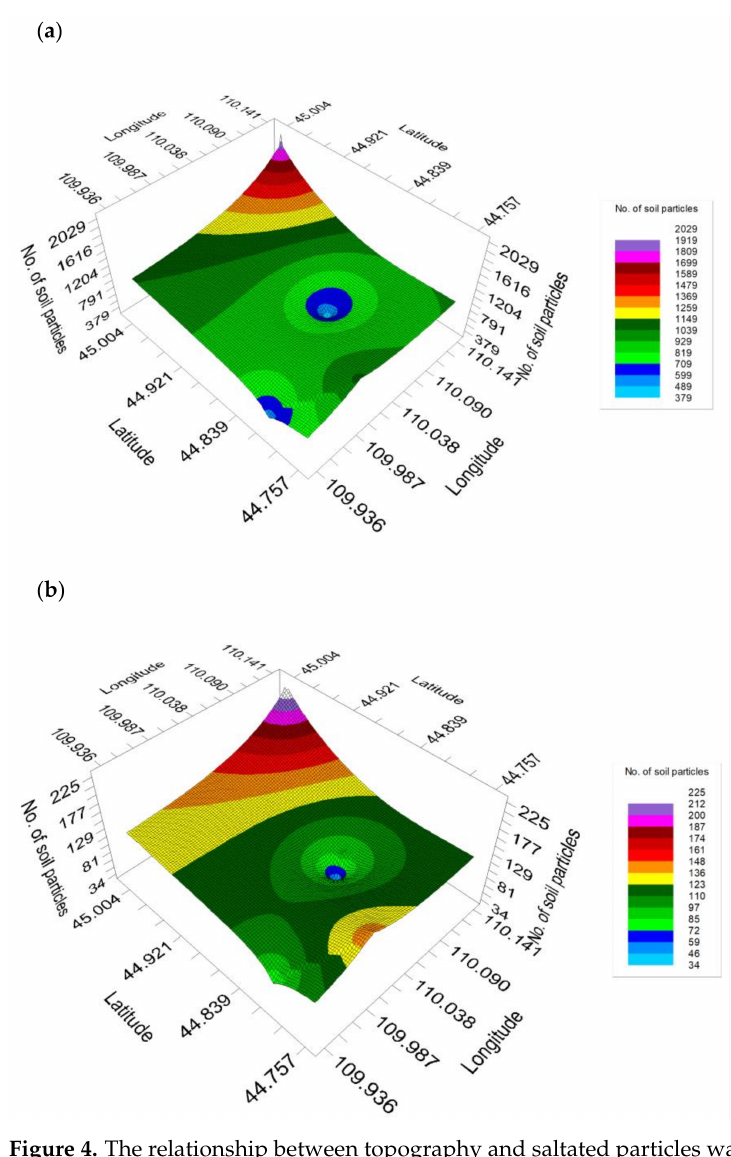
Figure 4. The relationship between topography and saltated particles was analyzed and drawn by GS + Geostatistics. The figure shows the dust scattering concentration at a critical wind speed of 9 m/s with latitude and longitude. ( a ) is 3 µ m particles, and ( b ) is 5 µ m particles. The number of bacteria on the ground surface at the four locations was detected at the DL (10 7.0 CFU/g), the WA (10 6.5 CFU/g), the WE (10 7.3 CFU/g), and the DS (10 6.4 CFU/g), and the saltation experiment revealed that approximately 1/1000 of the number of live bac- teria was saltated. Next, the total number of bacteria obtained from the culture of saltated bacteria in a container installed in the experiment tent was examined. In the examination of the number of saltated bacteria at four locations, 10 4 –10 4.9 CFU/g was detected for 10 min blown by the fan. The WE had the largest number of bacteria (10 7.3 CFU/g) detected from the ground surface, and the number of saltated bacteria was 10 4.9 CFU/g (Table